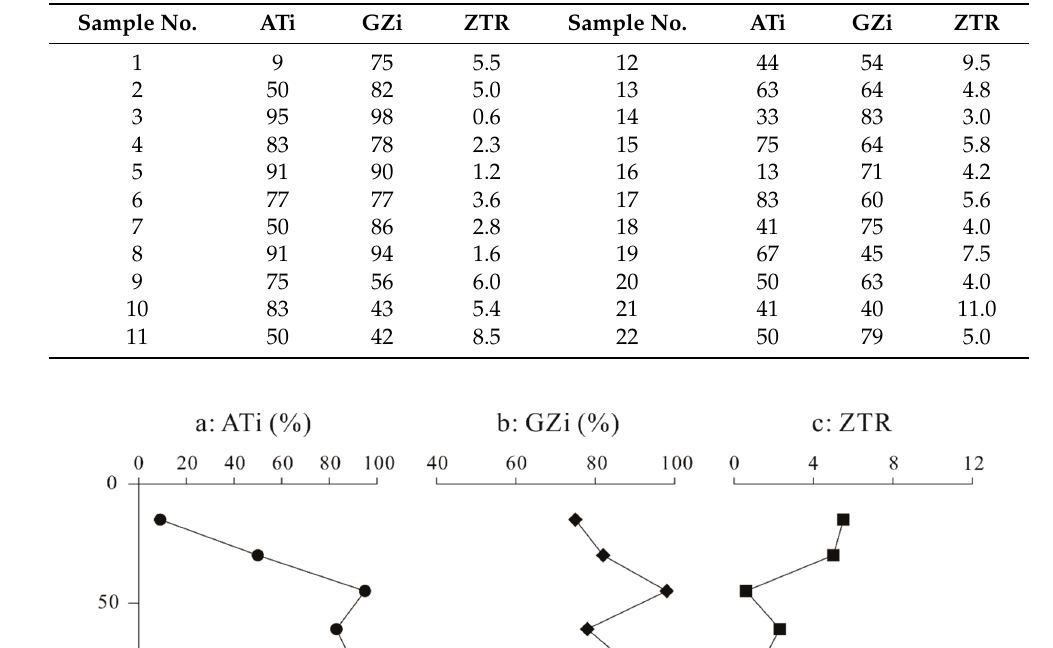
Table 2. Variation in ATi, GZi, and ZTR indexes through the Zhoulao core.